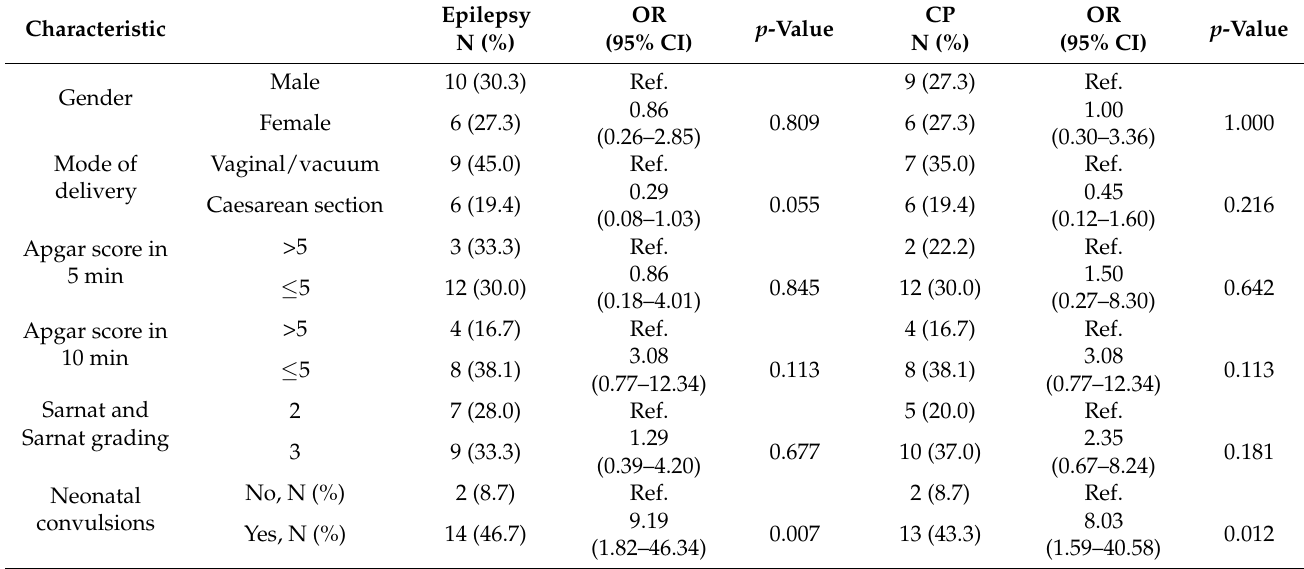
Table 2. Clinical characteristics of patients with epilepsy and cerebral palsy (CP).